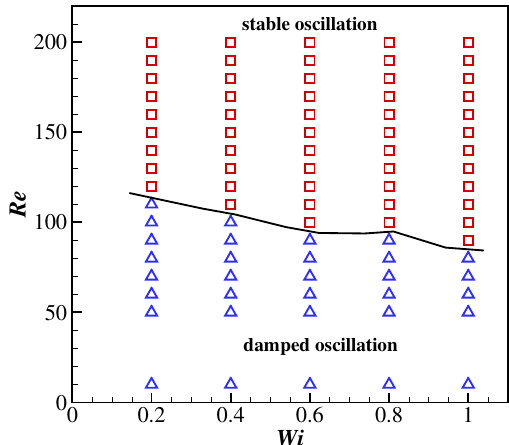
Figure 8. The phase diagram of a filament motion as a function of the Reynolds number and Weissenberg number. (cid:3) —stable oscillations; ∆ —damped